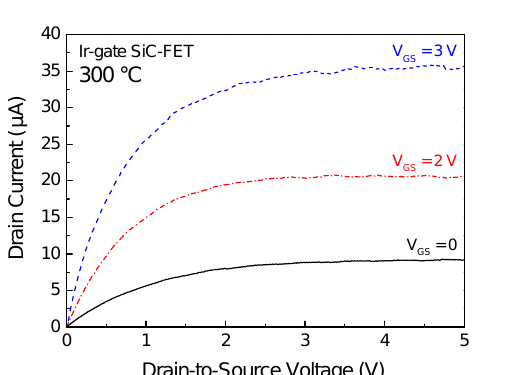
Figure 2. Current-voltage characteristics of an Ir-gate SiC-FET at 300 ◦ C with zero, 2V, and 3V applied gate bias, V GS , after expo- sure to